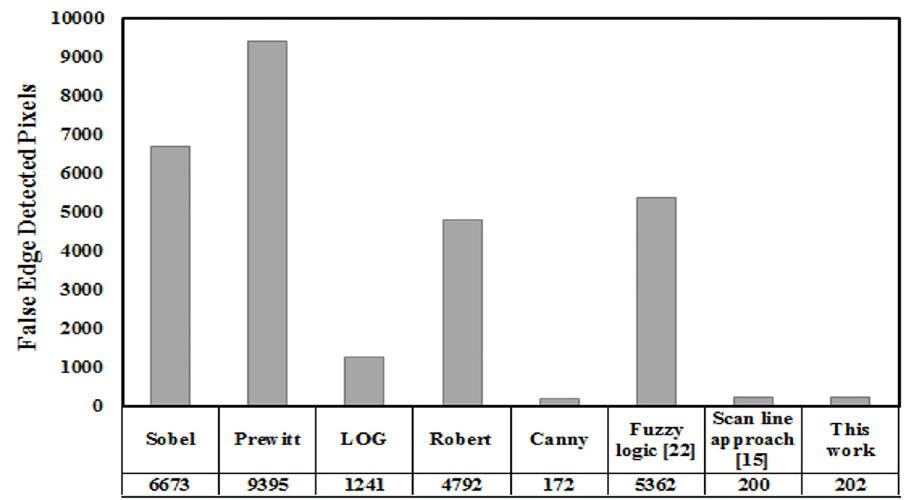
Fig 10. False edge detected pixels in a standard image of 512 x 512 pixels with 25 dB noise level: A comparison.